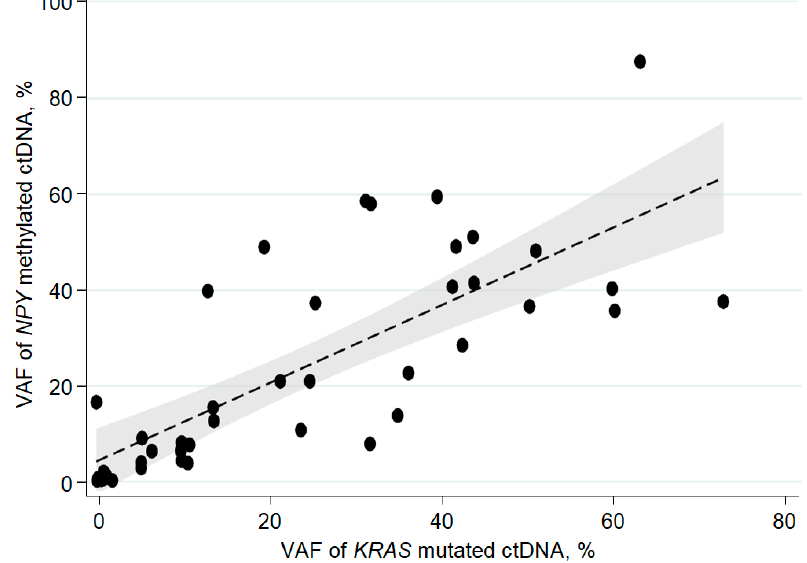
Figure 3. Correlation between baseline cell-free circulating tumor specific DNA (ctDNA) in the RAS mutation cohort measured by mutation or methylation, Spearman’s rho = 0.82, p < 0.001, n = 42. VAF = Variant allele frequency, dashed line is the linear regression line with 95% confidence interval in grey.